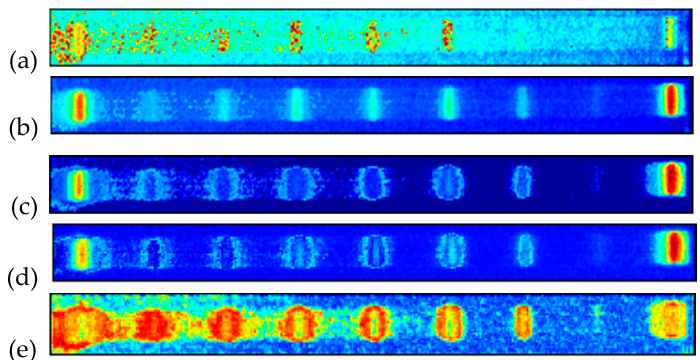
Figure 23. A single raw thermogram ( a ) and the exemplary results of the enhancement of damage detectability in the PMC elements of thermograms collected during SHVT inspection using: median value calculation ( b ), standard deviation value calculation ( c ), principal component thermography ( d ), undecimated discrete wavelet transform ( e